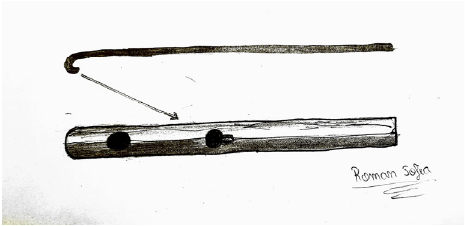
Figure 13. Kirschner wire angled hook.